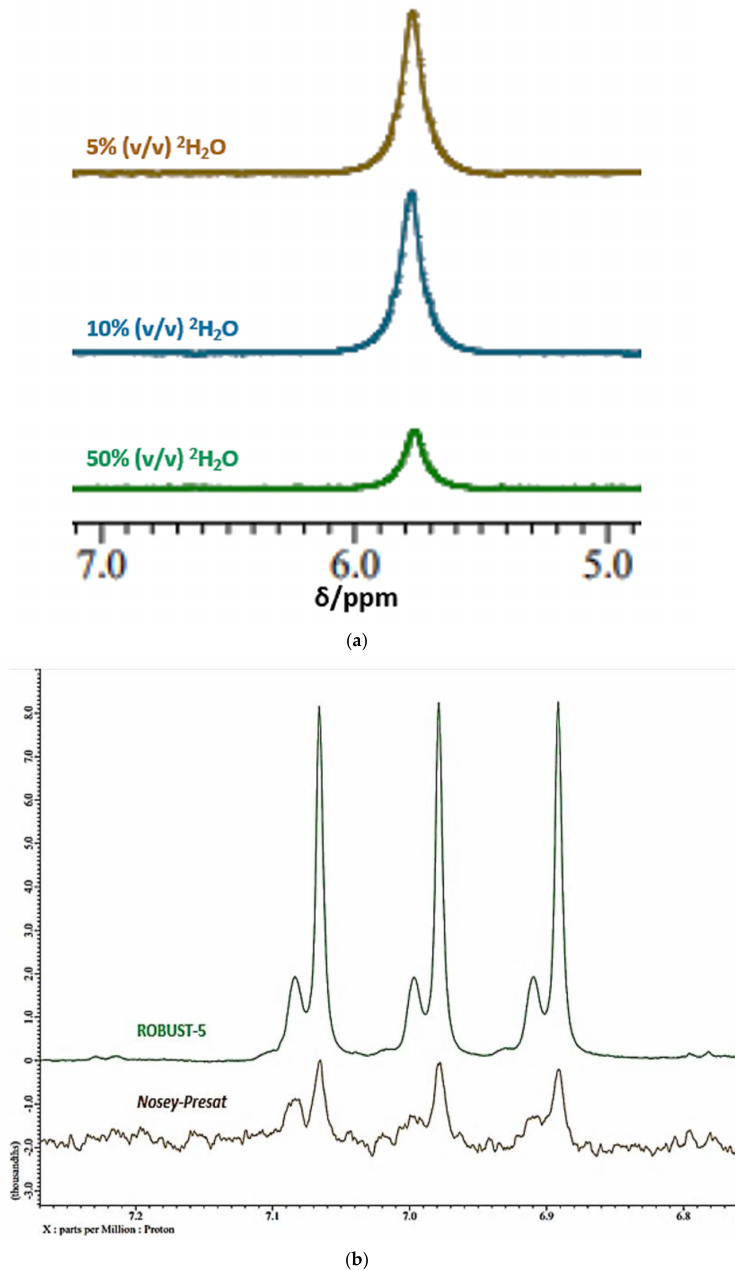
Figure 2. ( a ) 1 H NMR spectra of urea at increasing added % ( v / v ) 2 H 2 O solution contents. Shown are the 4.90–7.10 ppm regions of spectra of 10.00 mmol./L urea acquired in solutions containing 5 (brown), 10 (blue) and 50% ( v / v ) 2 H 2 O (green) using the Robust-5 pulse sequence. Samples also contained 10.00 mmol./L phosphate buffer (pH 7.00), and were equilibrated for a minimum duration of 1.0 h at ambient temperature (22 ◦ C) prior to 1 H NMR analysis. Spectra were obtained on a Jeol JNM-ECZ600R/S1 NMR spectrometer operating at a frequency of 600.17 MHz. Acquisition parameters were: sweep width 9 kHz; 16,384 data points; relaxation delay 1.0 s; 128 transients; and sweep width of 11,218 Hz. Broad urea resonance intensities were normalised to that of a TSP internal standard (final added concentration 125 µ mol./L), with a chemical shift reference value